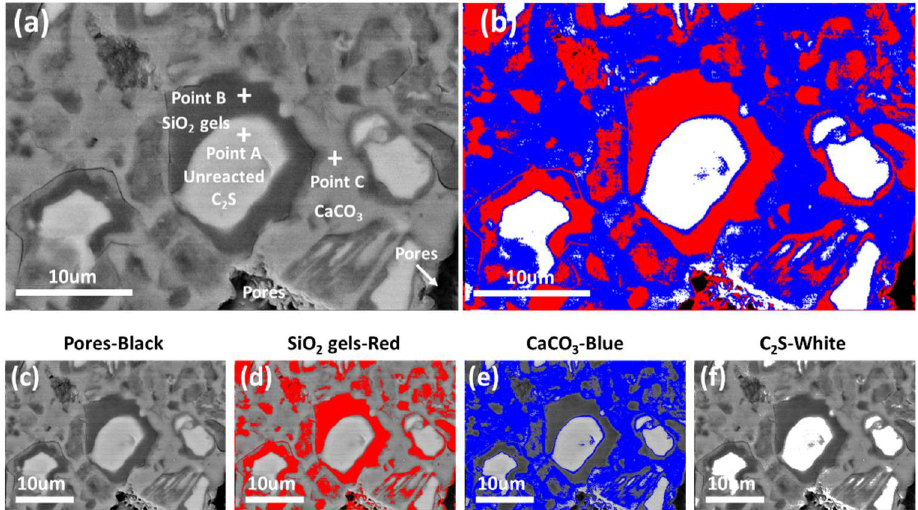
Figure 3. BSE images and phase distribution maps of β-C 2 S after carbonation. ( a ) BSE image; ( b ) images of the composite phases; ( c–f ) images of the individual phases after the gray level separation.